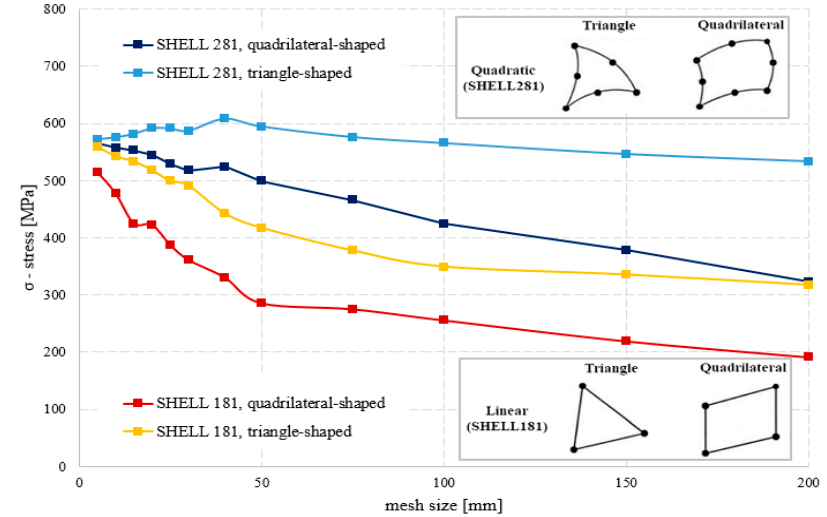
Figure 8. E ff ect of fi nite element type and shape on the maximum stresses.